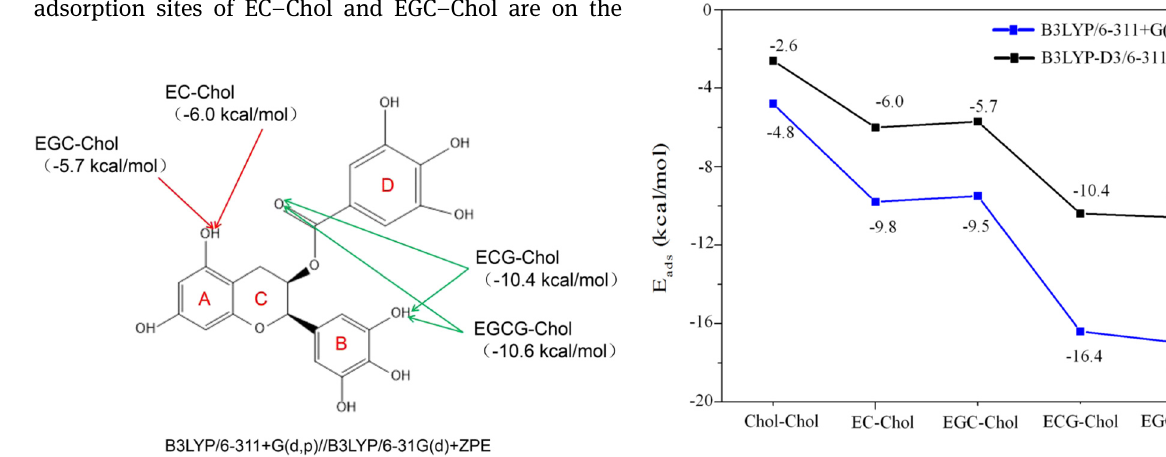
Figure 3: Schematic diagram of adsorption sites.